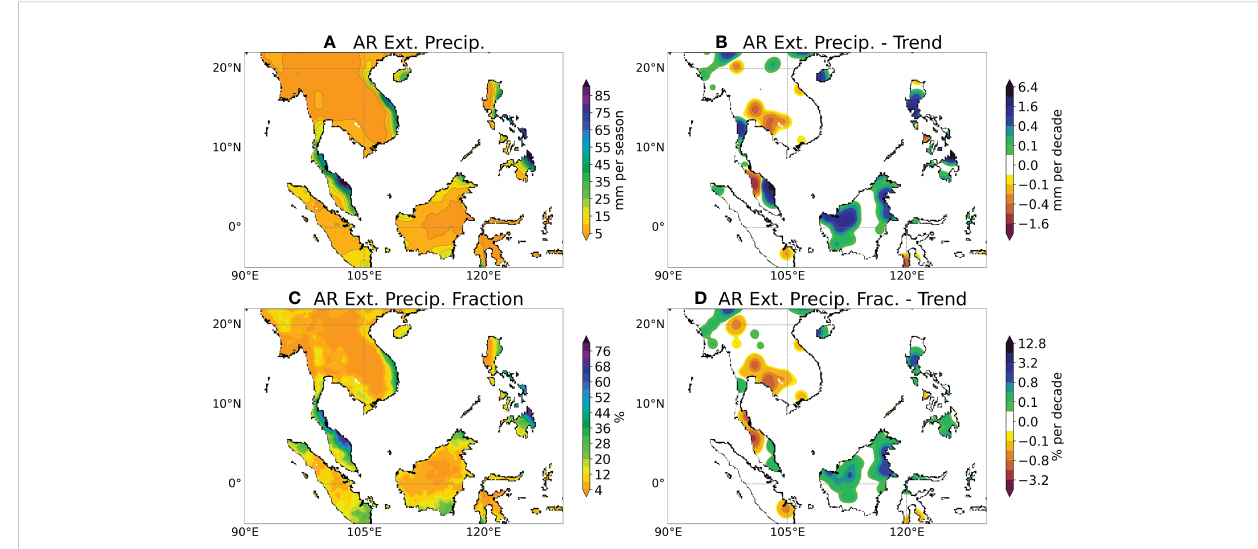
FIGURE 6 As for Figure 5, but for the contribution of ARs to the extreme precipitation